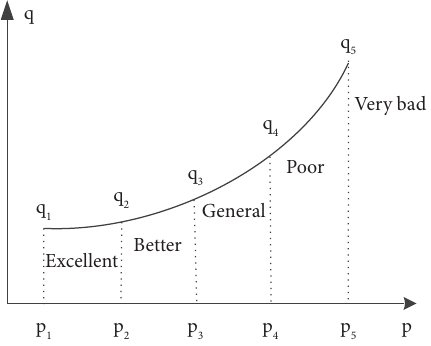
Figure 15: Design criterion ranking function.